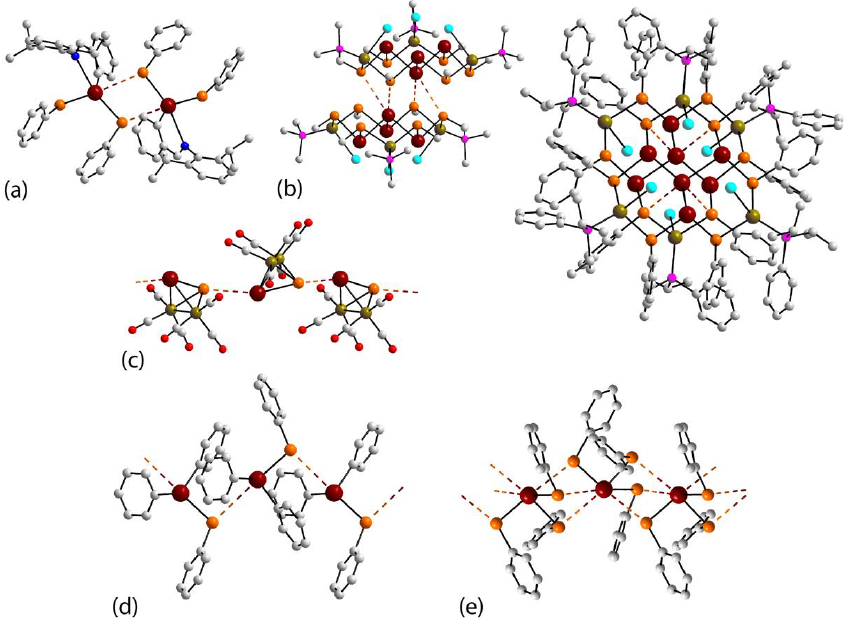
Figure 11. Supramolecular aggregation via Bi … Se secondary bonding in (a) 36 {KIMMEA; d(Bi … Se) = 3.51 & 3.55 Å }, (b) 38 {EGEPEM; 3.70 & 3.83 Å }, (c) 39 {COFGEM; 3.48 Å }, (d) 40 {GIPREC; 3.90 Å }, and (e) 41 {MIWFAA; 3.48, 3.50 & 3.57 Å }. Additional color code: silver and iron, dark-green.